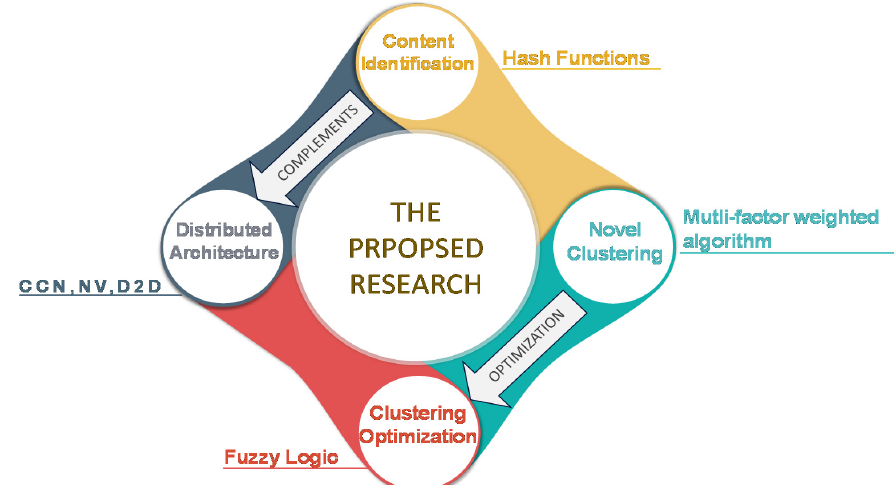
Figure 1. Summary of the Proposed Mechanism. The four critical aspects are: distributed architecture implementation using Content-Centric Networking (CCN) and Network Virtualization (NV), identification of users with common interest using hash functions, cluster formation with the proposed multifactor algorithm and optimizing the clustering algorithm using fuzzy logic.